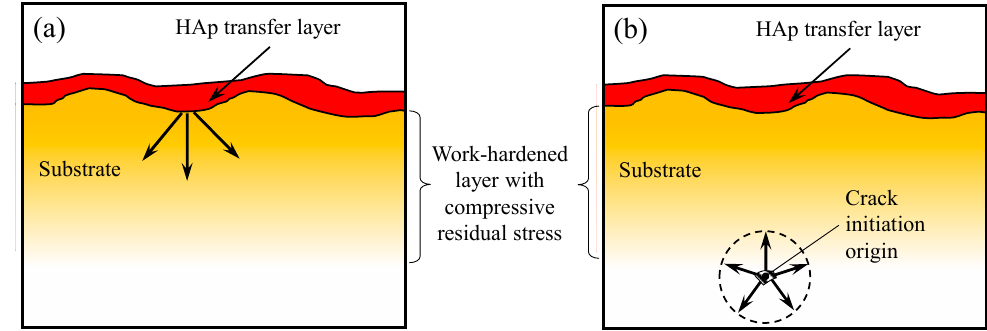
Figure 11. Schematic illustration of fracture mechanism for FPP-treated specimen failed at ( a ) high and ( b ) low stress